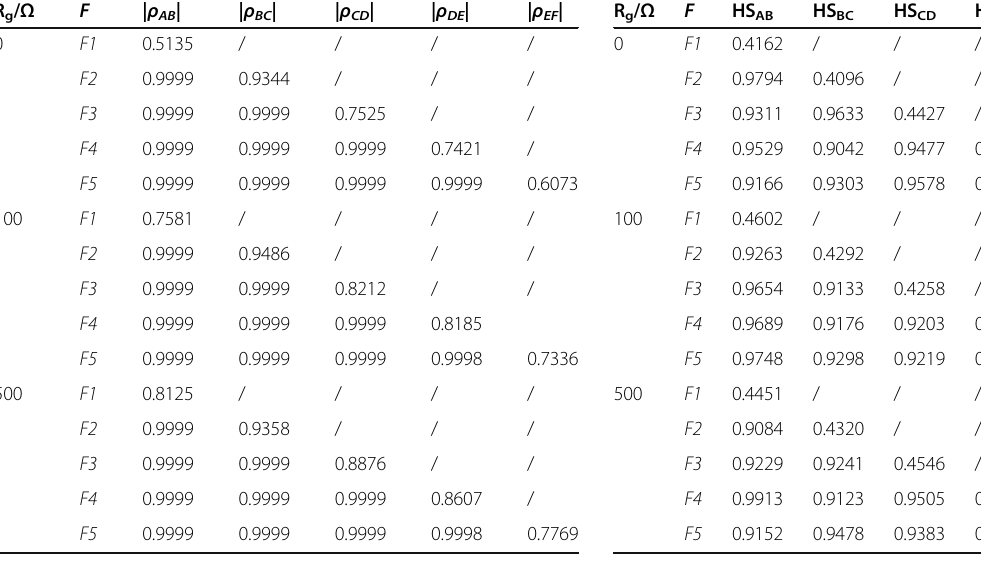
Table 3 Results of the correlation coefficient method ( φ = 0 ∘ )